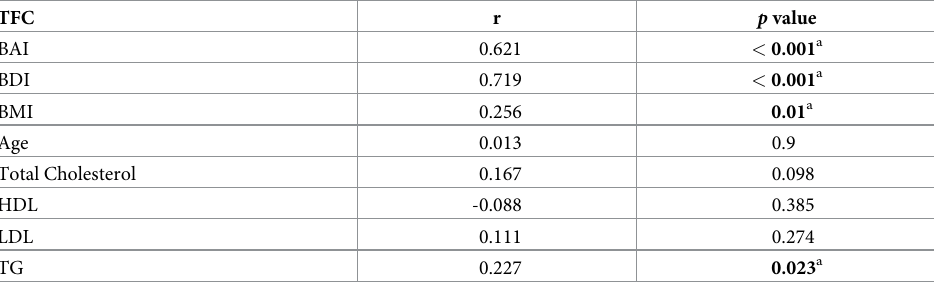
Table 2. Correlation between the TFC and (BAI, BDI).